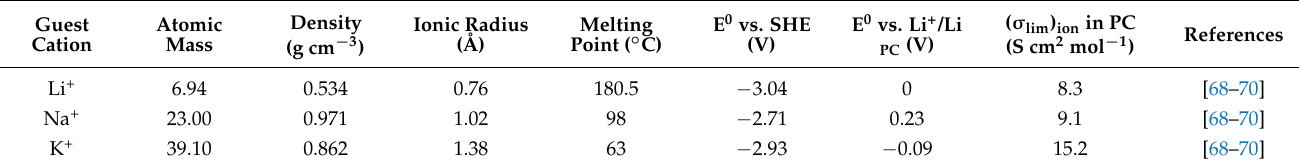
Table 2. Comparison of some physicochemical properties of Li + , Na + and K + ions for possible use in rechargeable non-aqueous